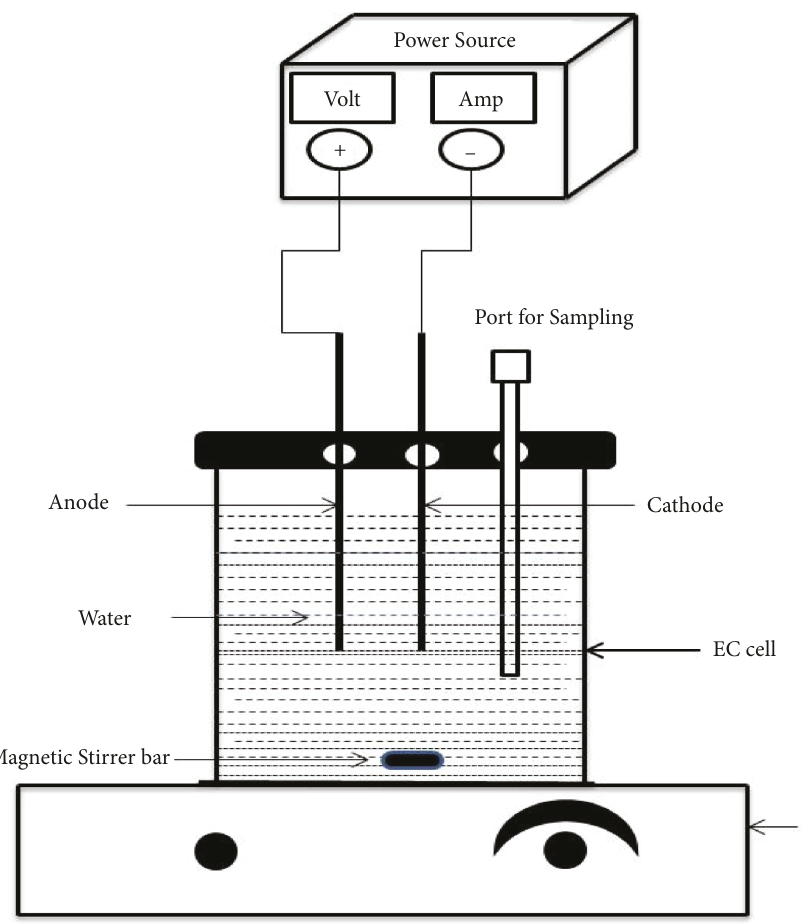
Figure 1: Electrocoagulation process experimental